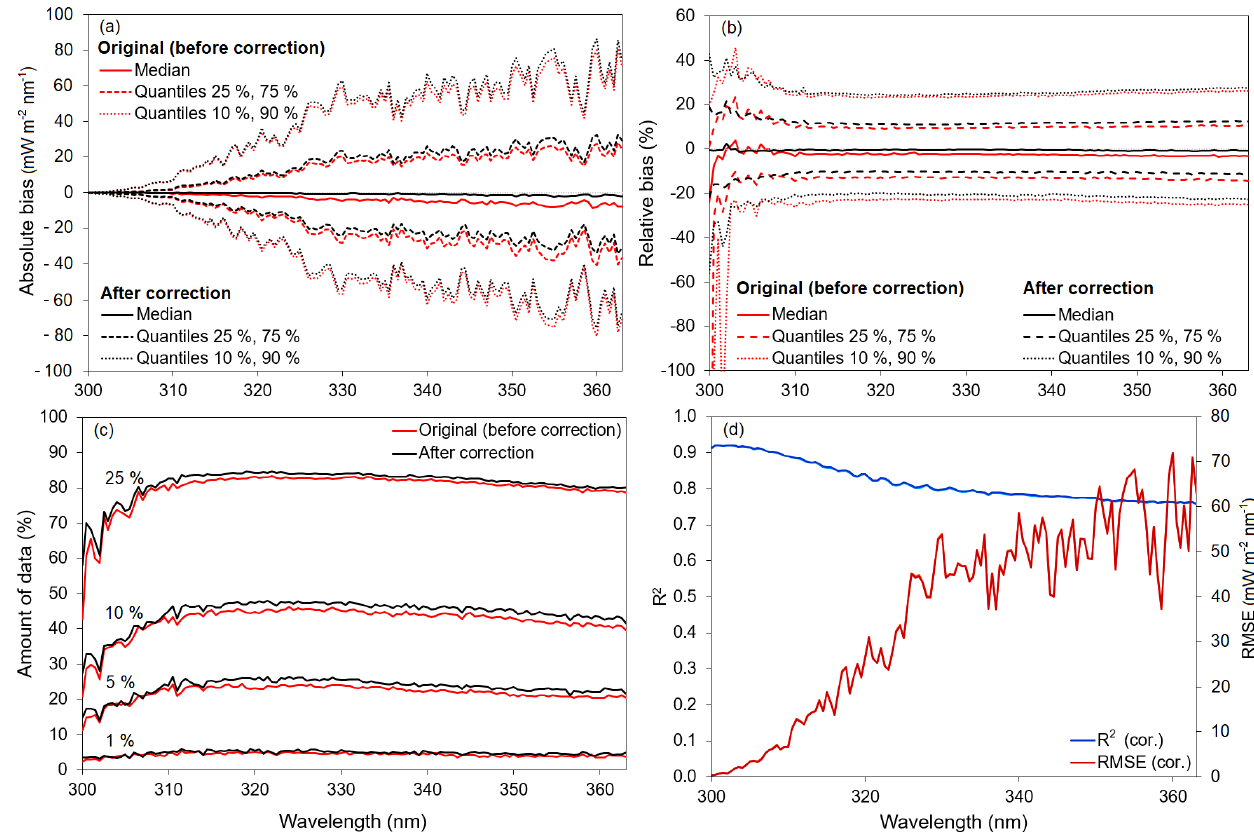
Figure 3. Validation of the ANN model before and after the median correction, where (a) represents the absolute bias quantiles; (b) is the relative bias quantiles; (c) is the number of data within 1%, 5%, 10%, and 25% from observations; and (d) is the R 2 and